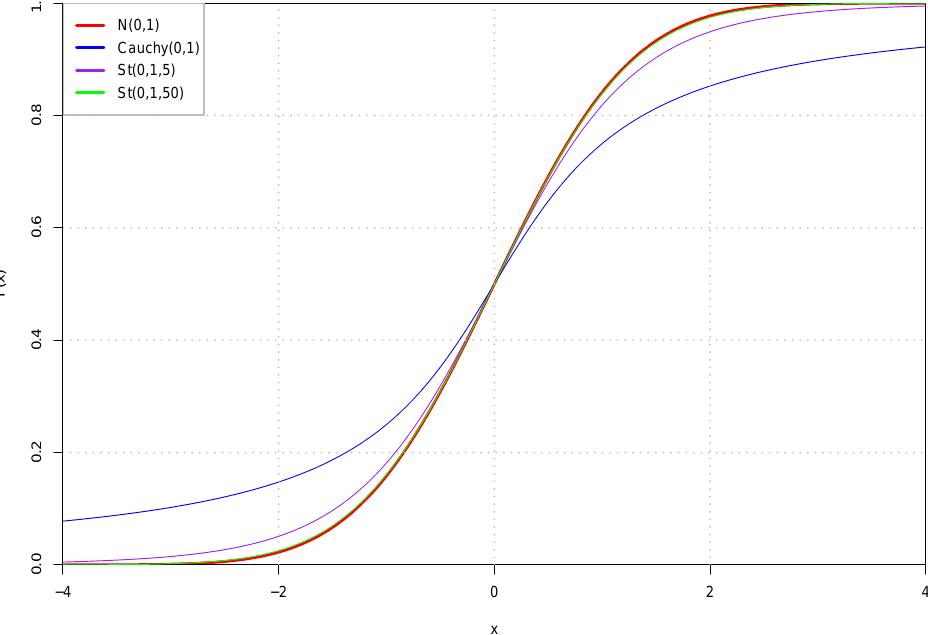
Figure 2. Several cumulative distribution function curves of common probability distribution. They share the same mean and scale parameters, and there are two St distribution with dof parameter 5 and 50,